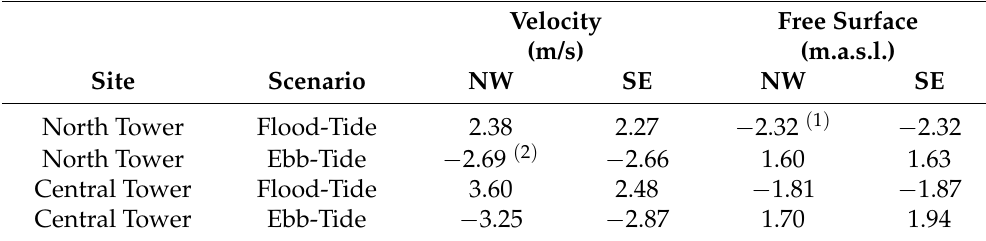
Figure 3. ( a ) Definition of the modelling domain at the CT. ( b ) Definition of boundaries of the numerical domain. ( c , d ) show a views of the refined mesh used for numerical modelling. Figures adapted from [29]. Table 2. Boundary conditions at NW and SE sides of the numerical domain of both sites obtained from a large-scale numerical model built in a Mike21, using the non-linear shallow water equations for extreme tidal ranges [29]. ( 1 ) A negative value denotes a free surface under the sea level (=0 m.a.s.l.). ( 2 ) A negative value denotes a flow direction opposite to flood